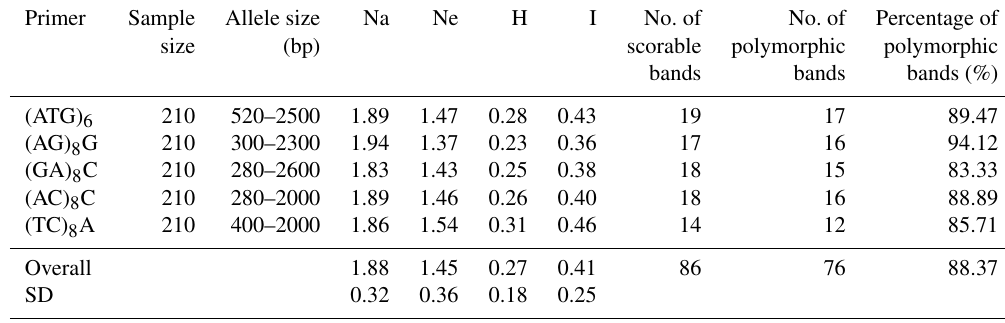
Table 3. Various measures of genetic variability among different goat breeds.